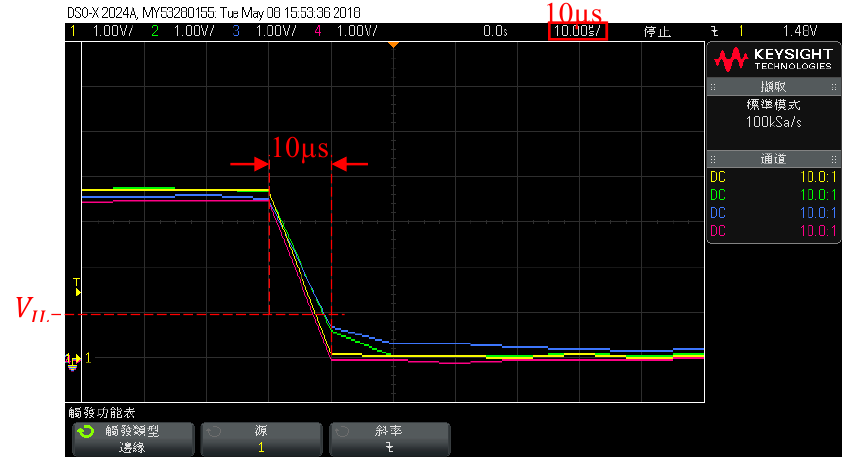
Figure 21. The time synchronization experiment assisted by PPS (pulse-per-second) of GPS (global positioning system).